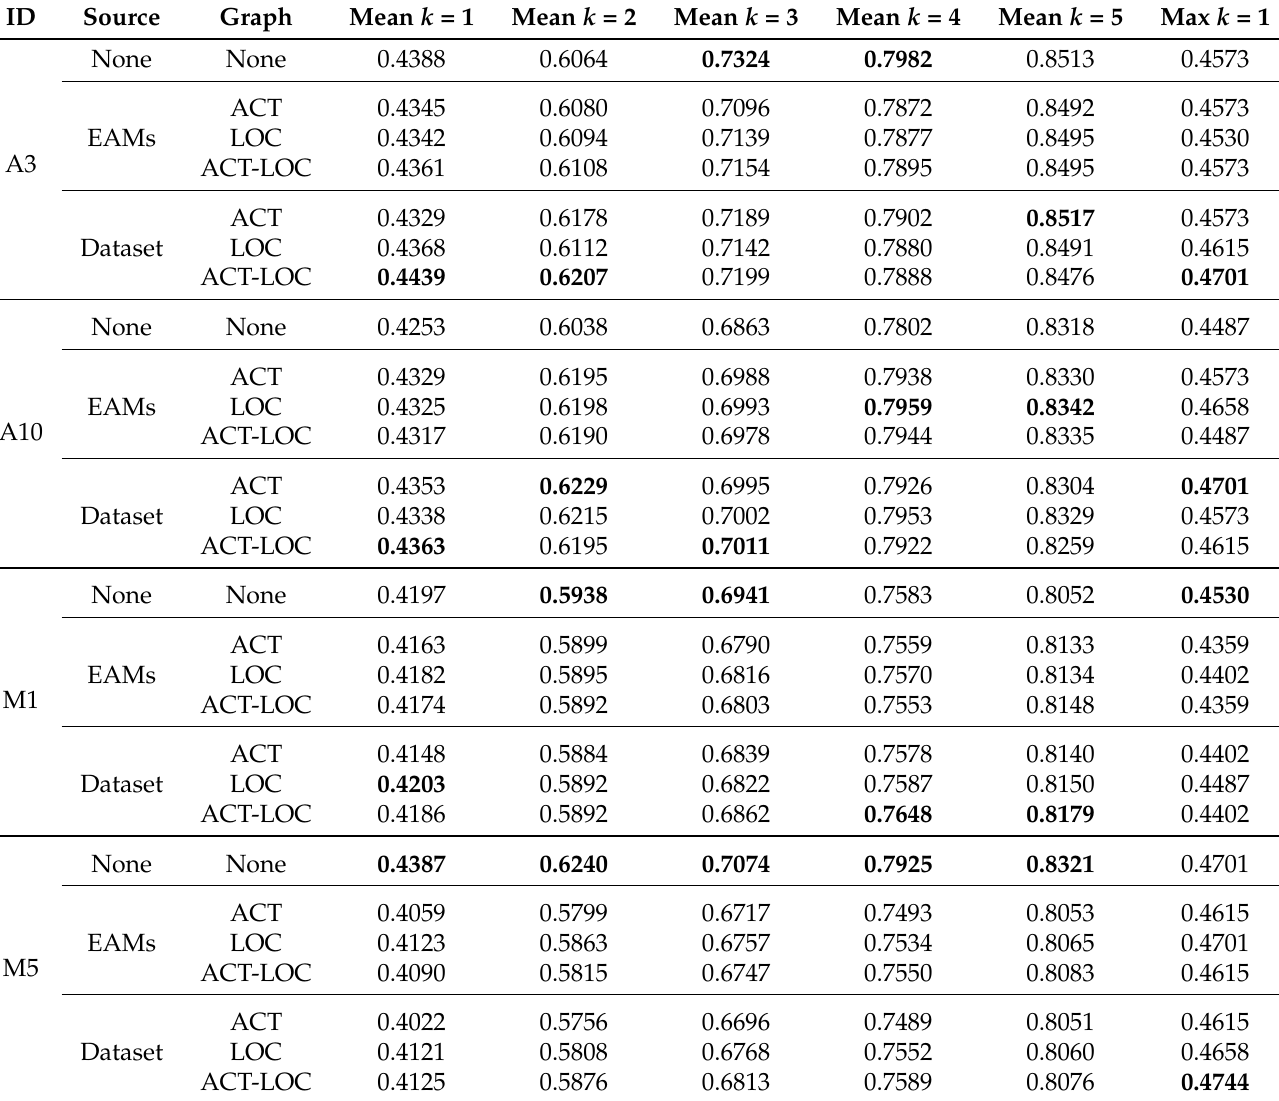
Table 3. Retrofitting experiments with different knowledge graphs. Accuracy at k . Mean accuracy for 100 executions. Maximum accuracy at 1 is also reported. ID is the architecture identifier. Source is the information from which the knowledge graph was generated. EAM: expert activity model, Dataset: information from Kasteren et al.’s manuscript [40] and the labeled data. Graph indicates the entity that was used to generate edges. ACT: activities, LOC: locations, ACT-LOC: activities and